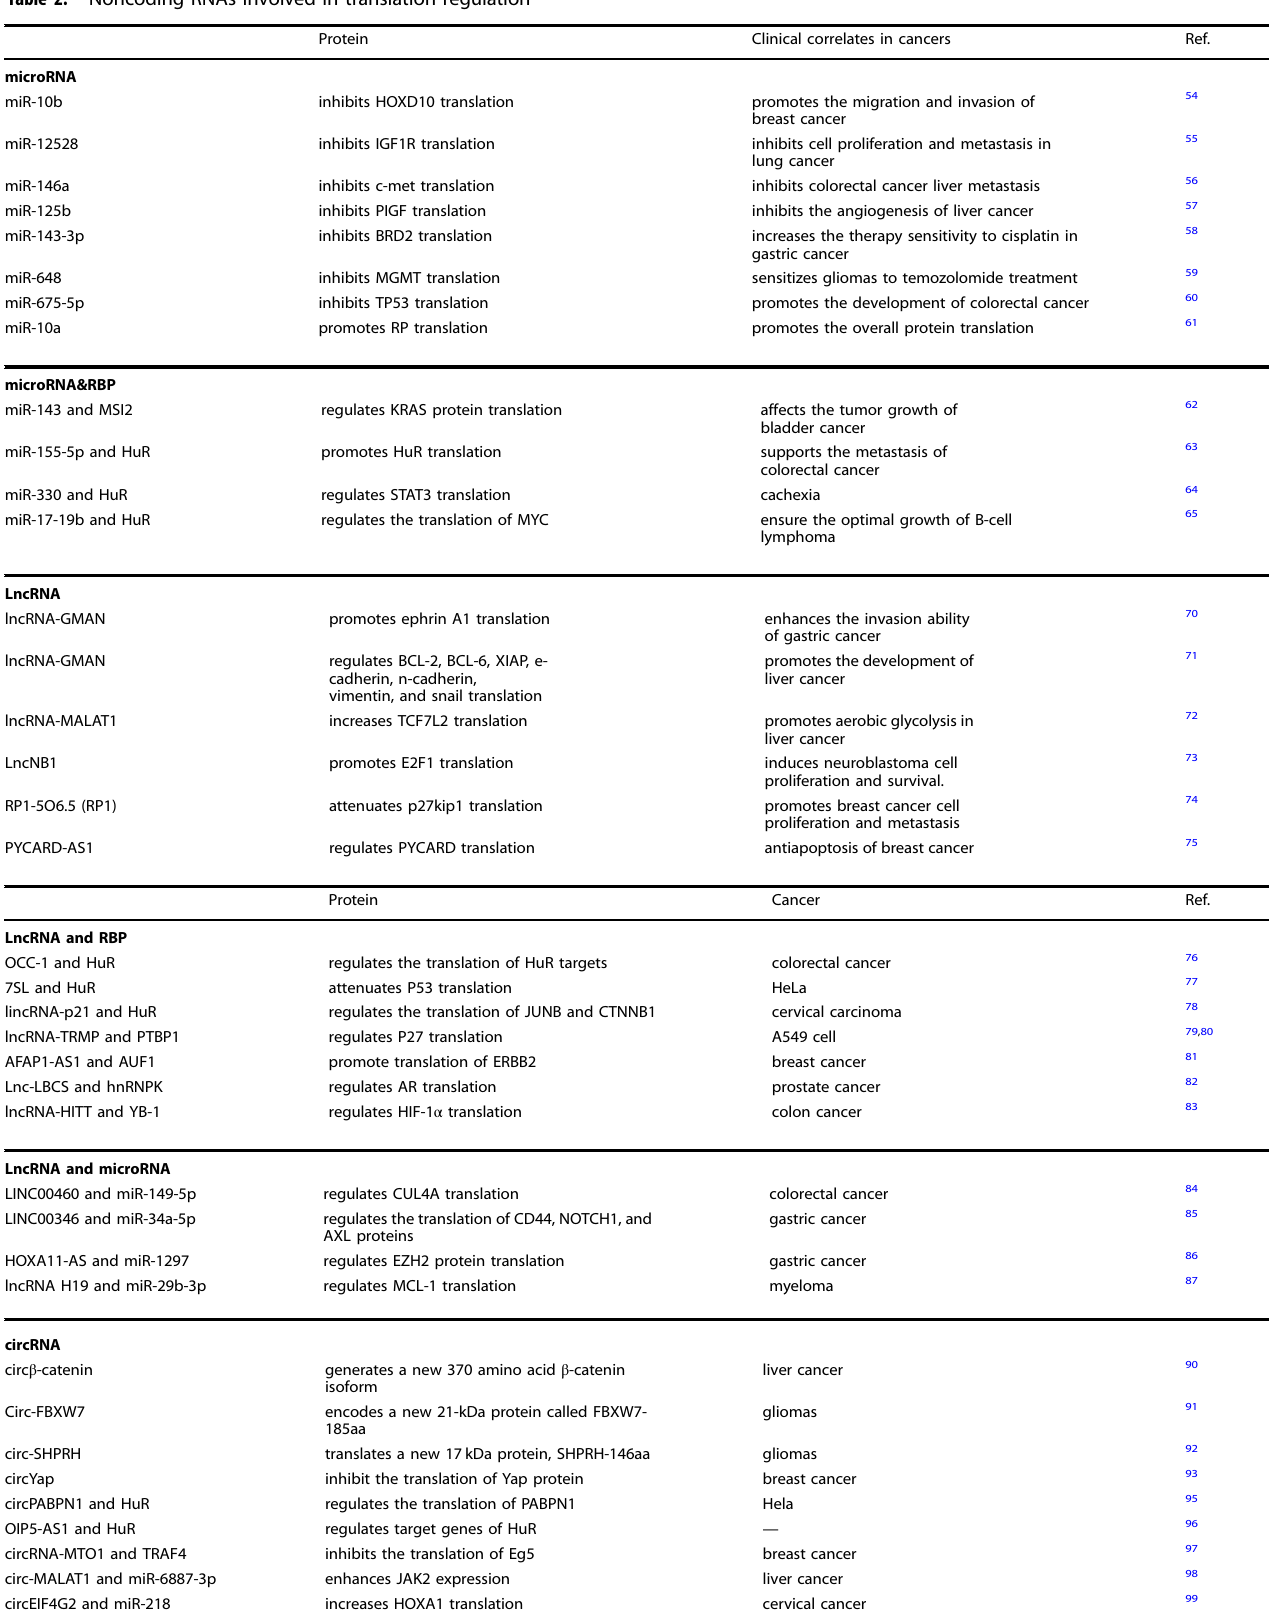
Table 2. Noncoding RNAs involved in translation regulation Protein Clinical correlates in cancers